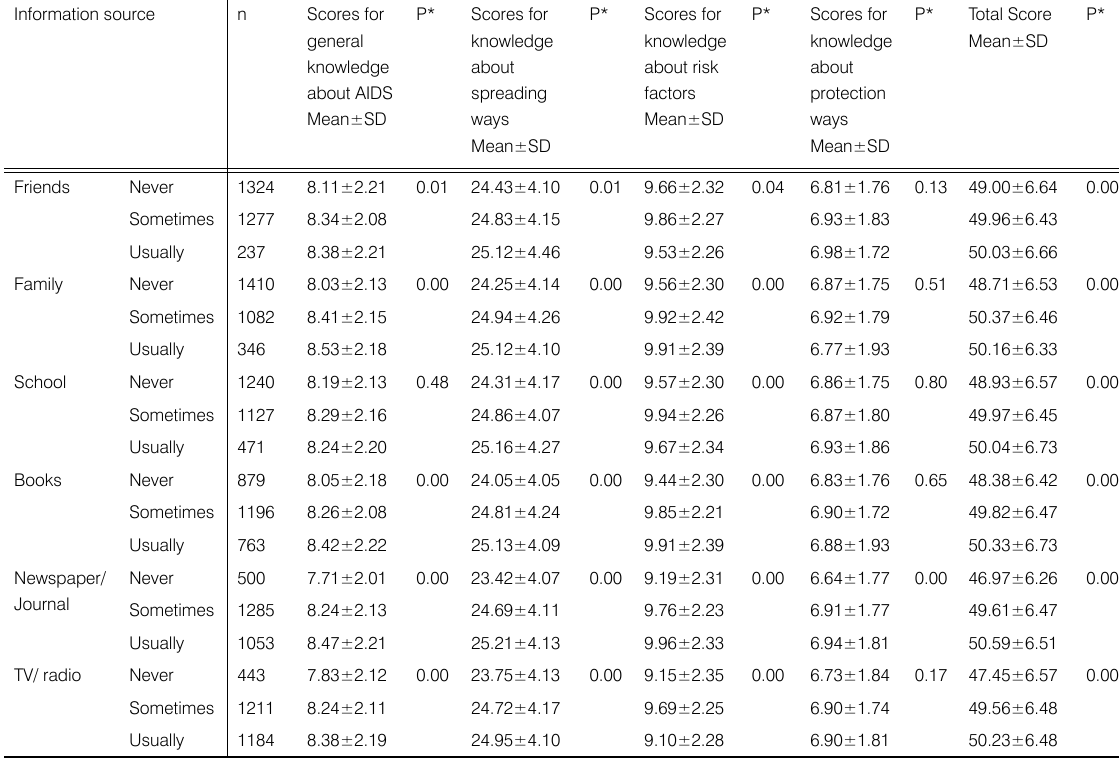
Table 3 The knowledge levels of students about AIDS with regard of their habits of using information sources Information